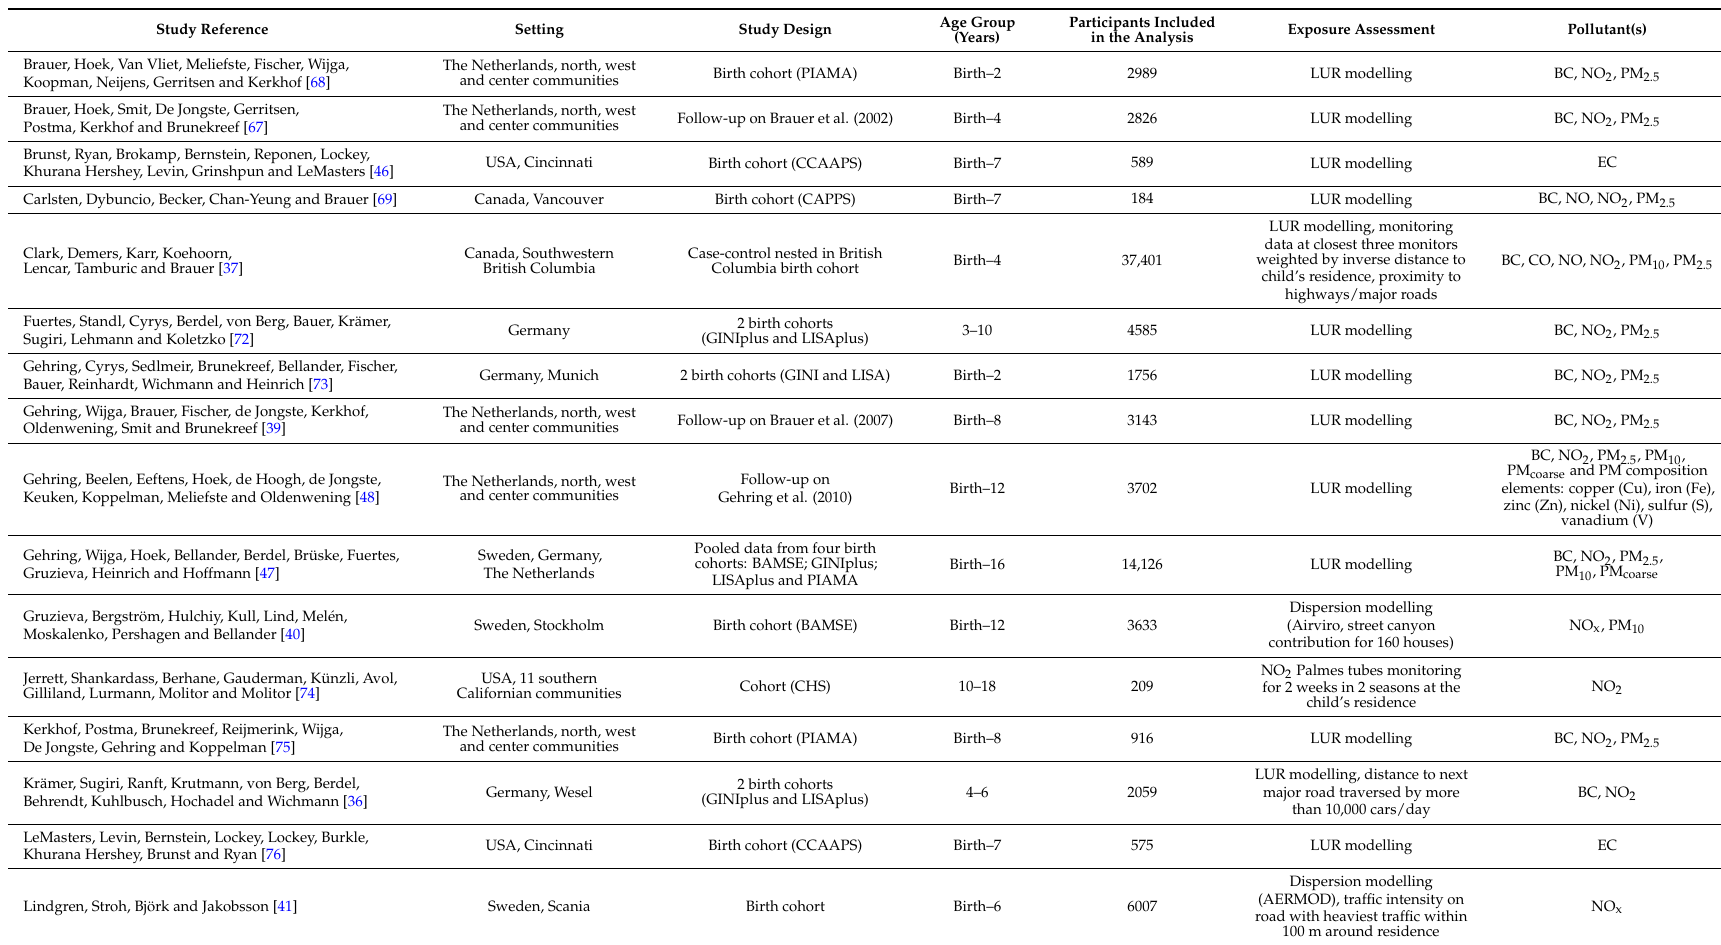
Table 1. Main characteristics of the included